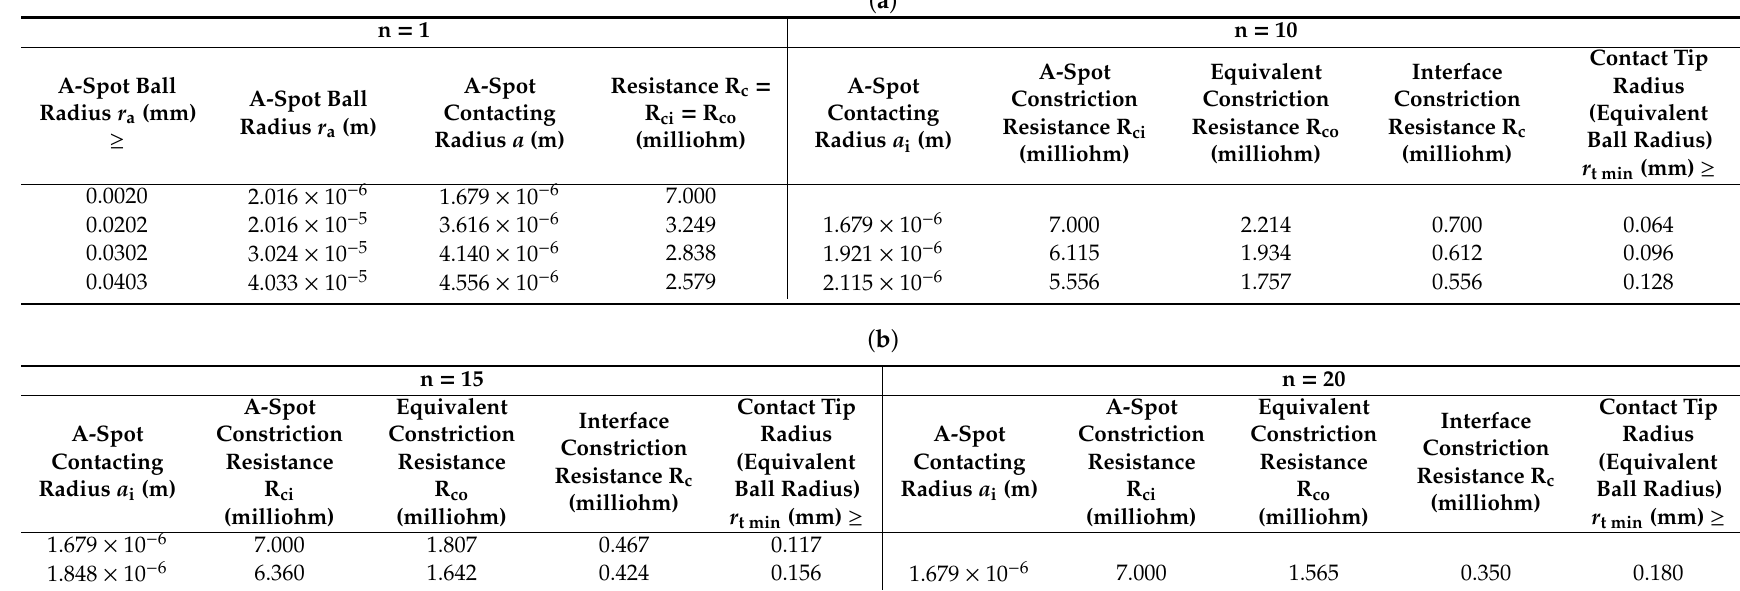
Table 2. Design parameters with di ff erent